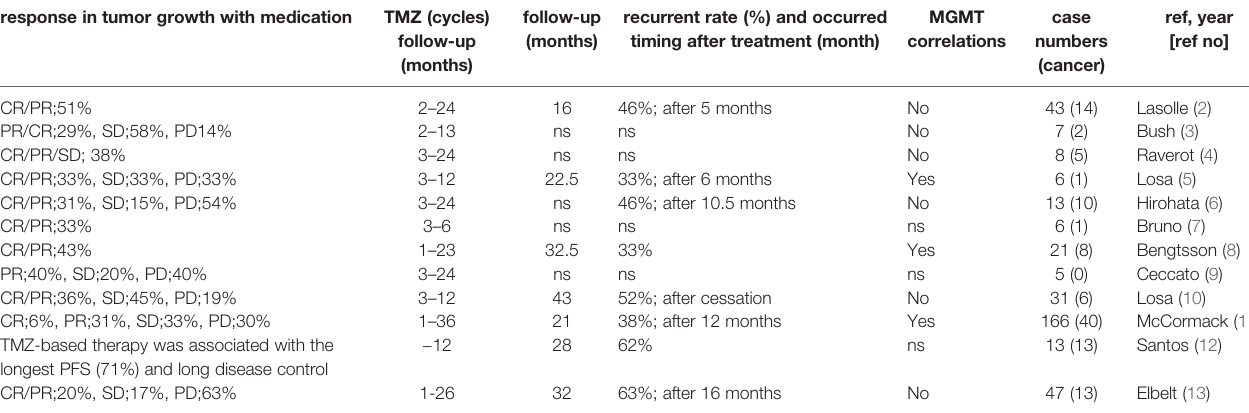
TABLE 1 | Temozolomide (TMZ) treatment response in pituitary tumors and carcinomas from published case series of 5 or more patients. response in tumor growth with medication TMZ (cycles)